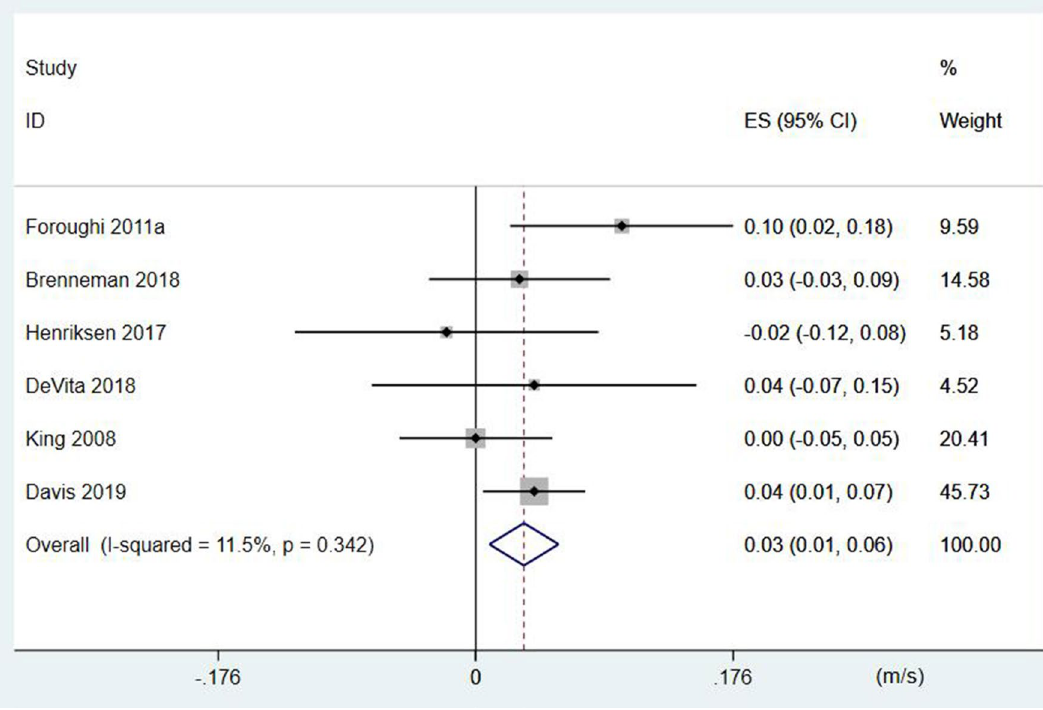
Figure 2. The forest plot of the effect size for studies assessing the effect of resistance exercise on the gait velocity of patients with knee osteoarthritis. The summary effect estimates for the individual studies are indicated by the gray rectangles, with the size of the rectangles proportional to the study weight. The lines represent 95% CI. The overall summary effect estimate and 95% CI are indicated by the diamond shape.